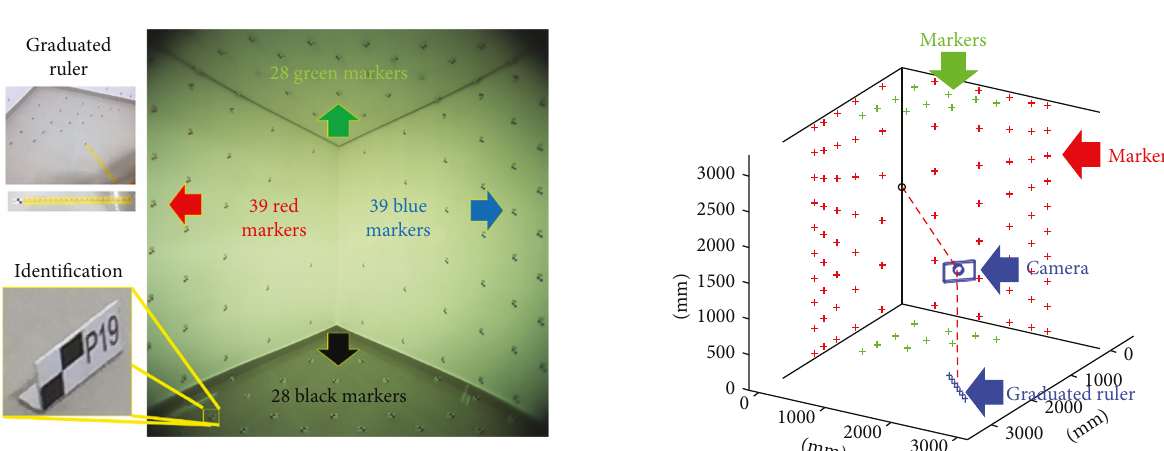
Figure 18: IPEV ’ s geometric calibration fi eld. Detail for identi fi ed markers and positions marked on the fl oor for camera positioning. Figure 19: Simulation of the positioning of each marker in the calibration fi